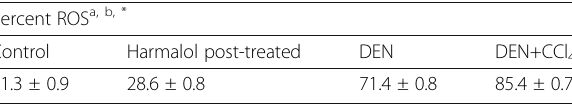
Table 5 Comparison between quantitative assay of ROS generation induced by harmine by DCFH-DA in HeLa cell lines through Flow cytometric analysis Percent ROS a, b, * Control a Average of three individual experiments at the same conditions b values represented means ±SD * Significantly different from the control groups ( p <